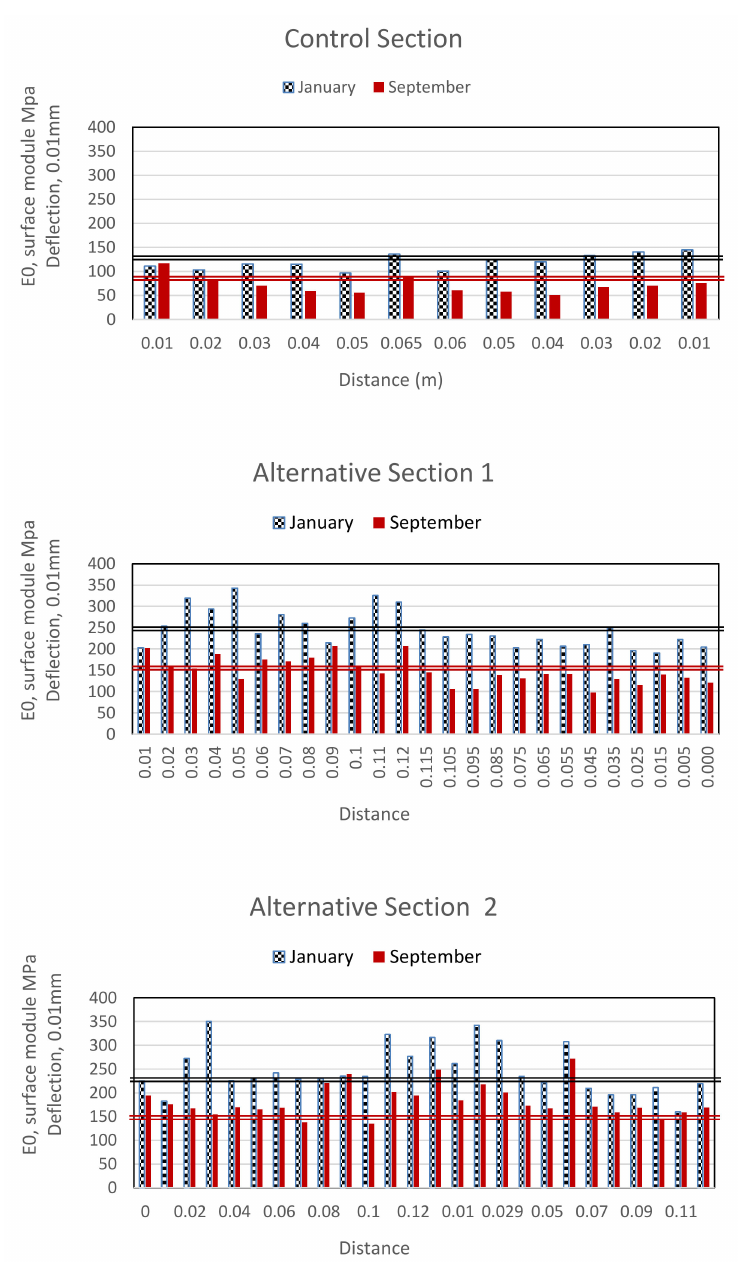
Figure 12. Deflection